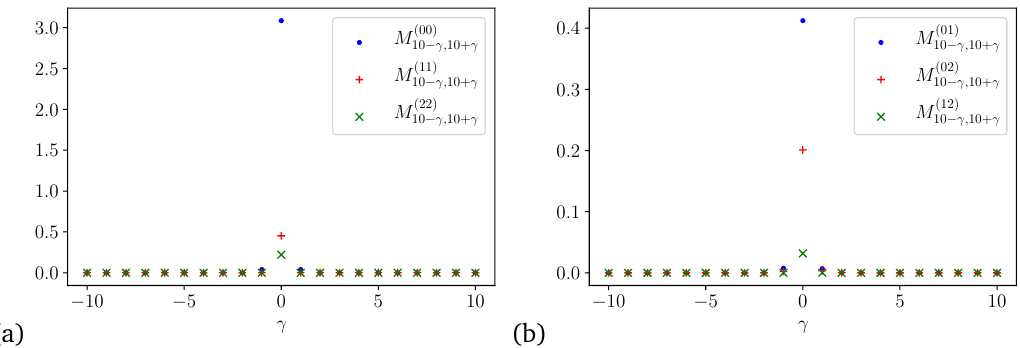
( ab ) , defined in Eq. (66). The α , β